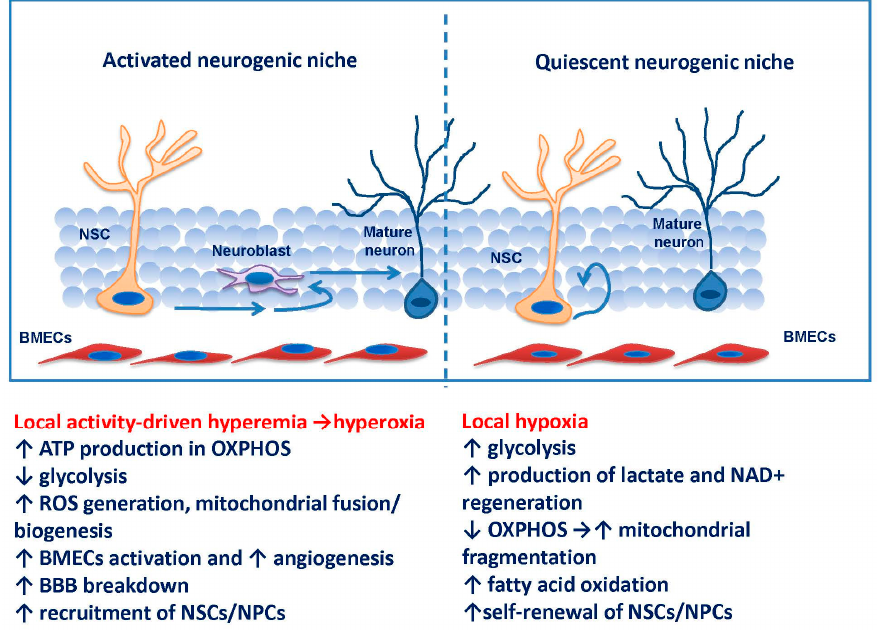
Figure 2. Metabolic reprogramming in NSCs/NPCs associated with conversion from the quiescent into activated state. Neurogenic niche is represented here as a simplified model. In a quiescent niche, relatively low oxygen tension keeps the cells out of cell cycle. Activation of neurogenesis by physiological stimuli (e.g., learning) is associated with functional hyperemia and local BBB breakdown to provide better access to pro-neurogenic factors, and with the switch from glycolytic to mitochondrial ATP production associated with mitochondrial biogenesis and oxidative stress to support proliferation and differentiation of cells.